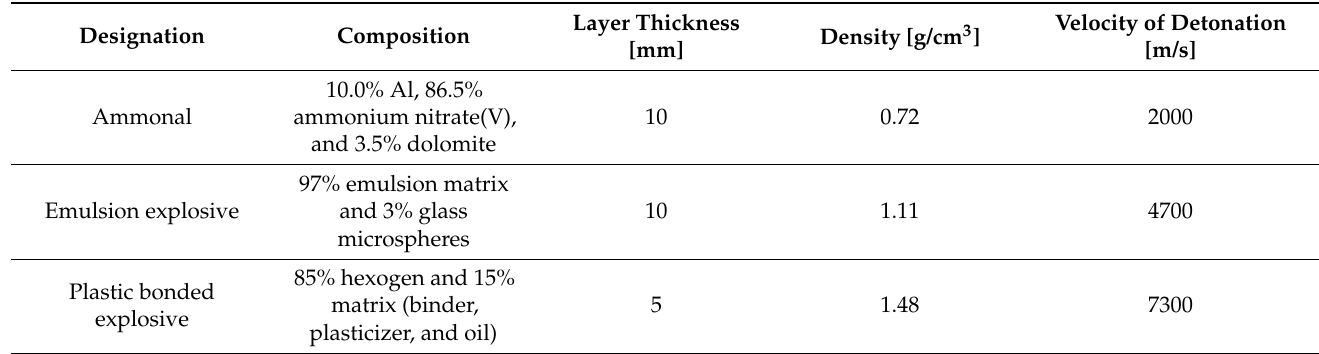
Table 2. Characteristics of explosives.